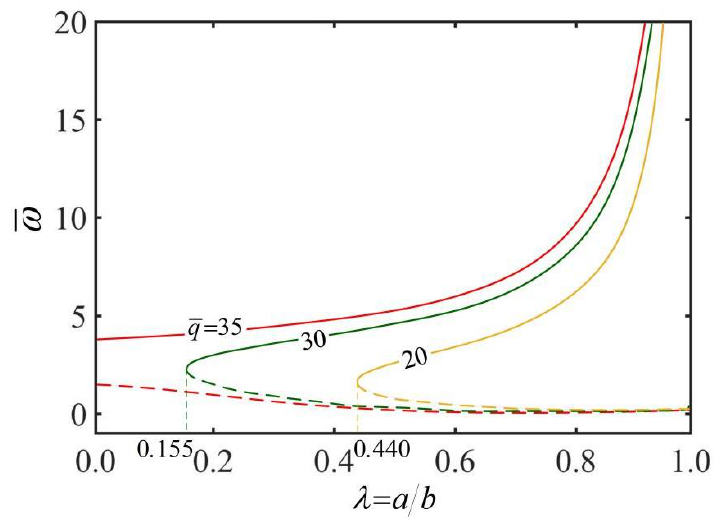
Figure 7. The effect of radius ratio λ on the rolling angular velocity ω of the thick-walled cylindrical rod for h = 0.3. The rolling angular velocity ω increases with the increase in radius ratio λ . There is a critical radius ratio λ crit for keeping the steady rolling of the thick-walled cylindrical rod, and λ crit decreases with the increase in heat flux q .